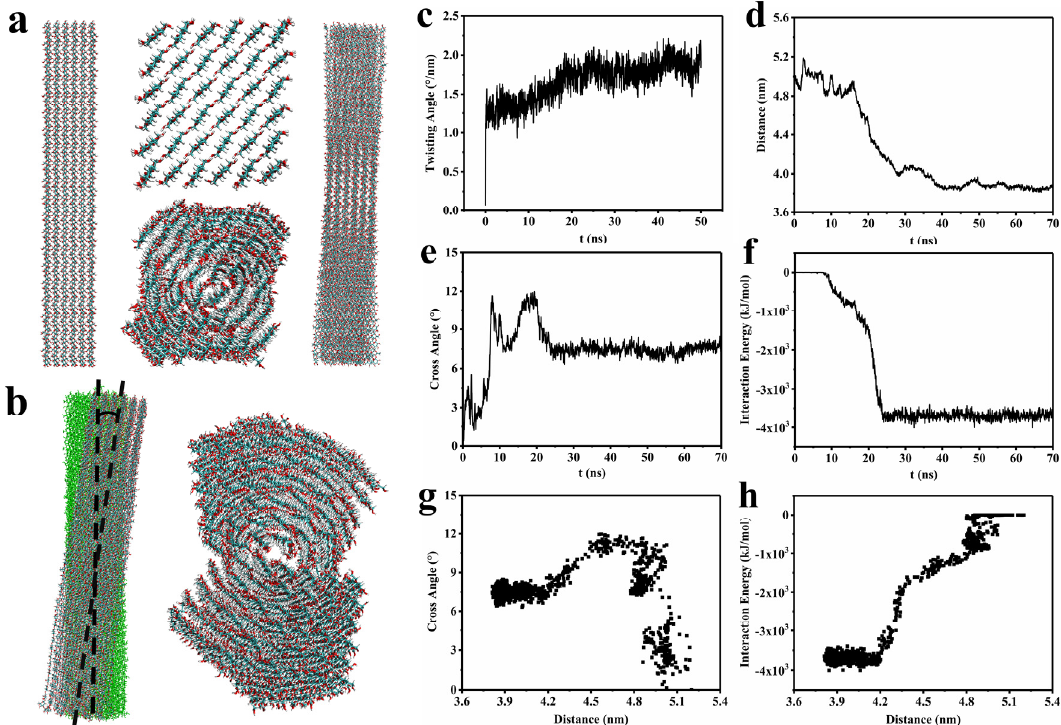
Figure 3. ( a ) Side views ( left ) and cross − sections ( upper middle ) of the initial structure and side views ( right ) and cross − sections ( lower middle ) of the twist structure. ( b ) Side view ( left ) and top cross − section ( right ) of the dimer system; the angle between the long axes of the two models was defined as the cross angle. The curves of ( c ) twisting angle, ( d ) distance, ( e ) cross angle, and ( f ) interaction energy vs. simulation time, respectively. ( g ) The relationships between cross angle and distance. ( h ) The relationships between interaction energy and distance.